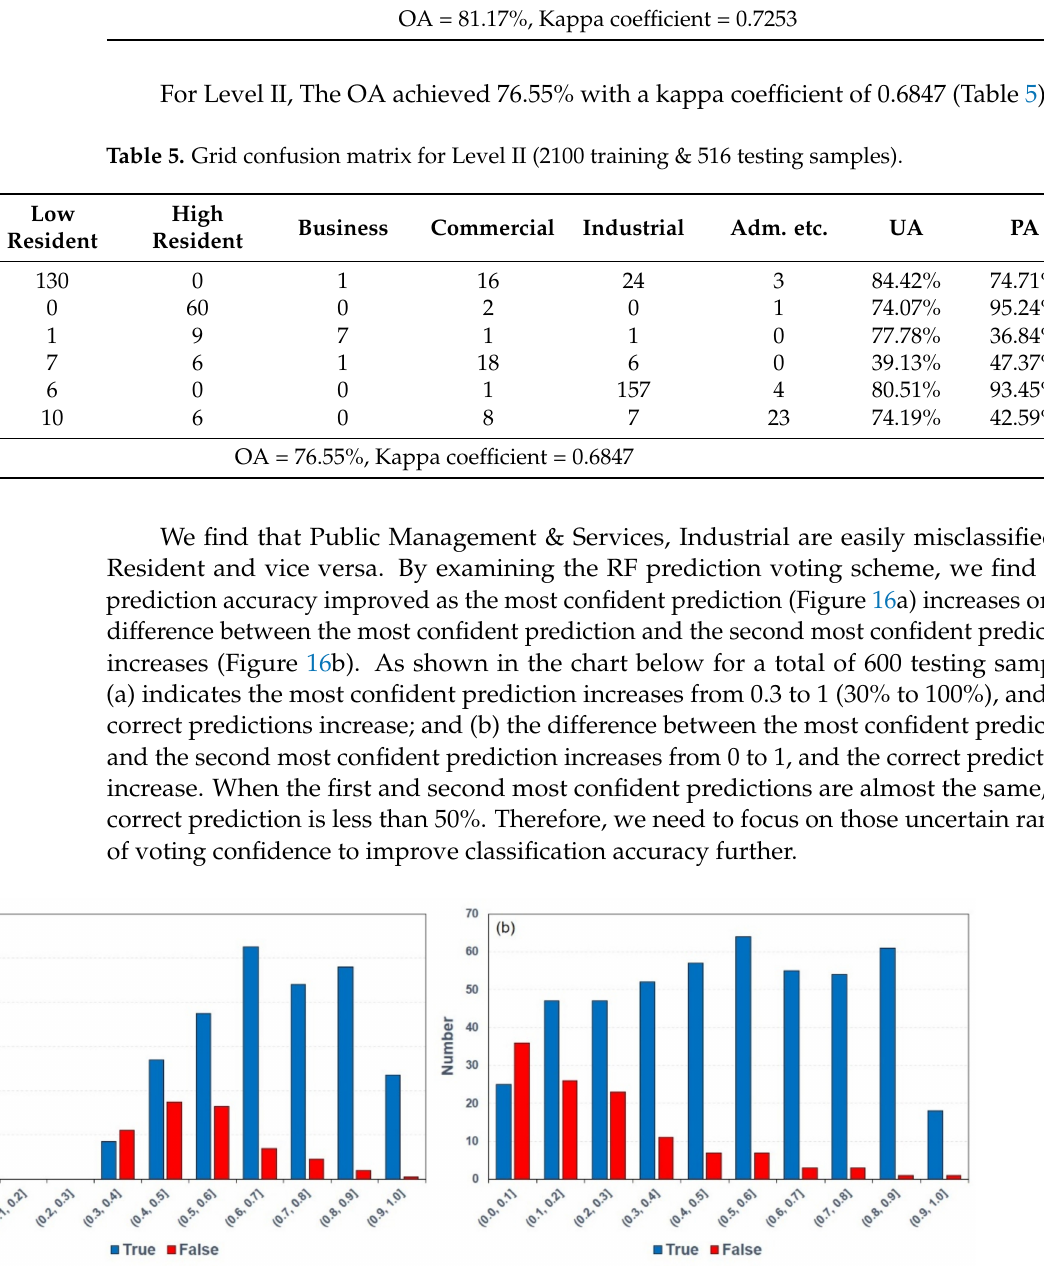
Figure 16. Prediction probability distribution of RF model: ( a ) most confident prediction; and ( b ) difference of the first and second confident